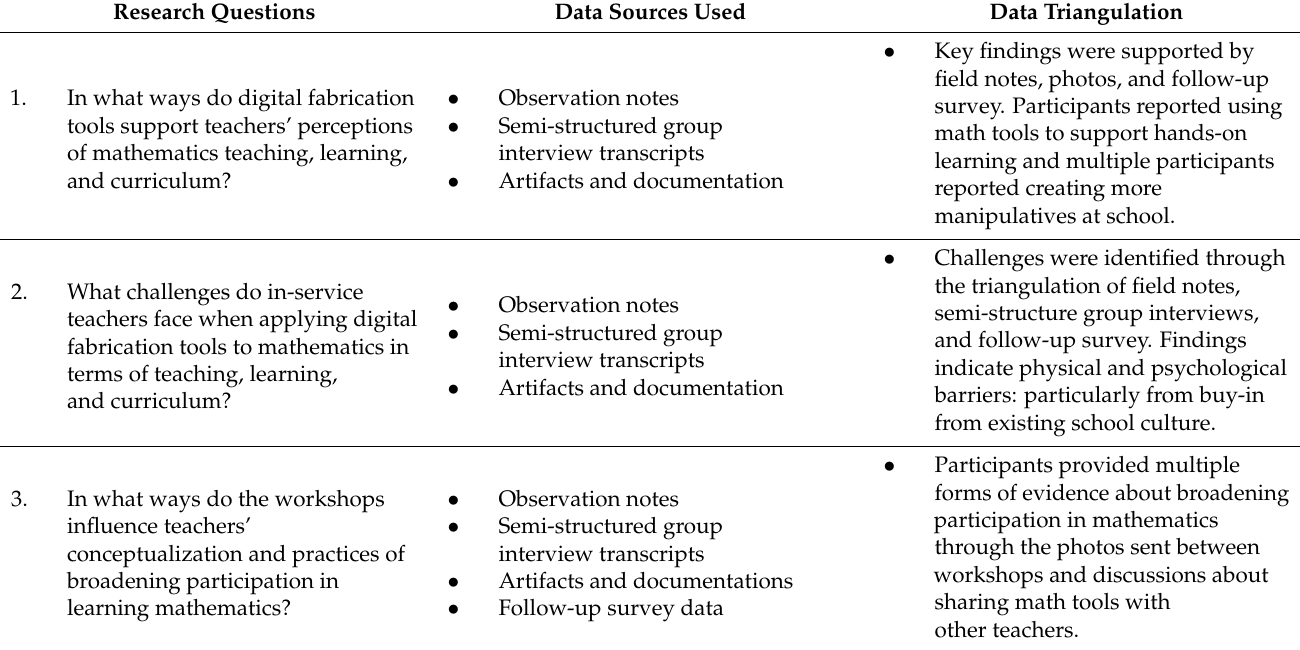
Table 2. Data sources and